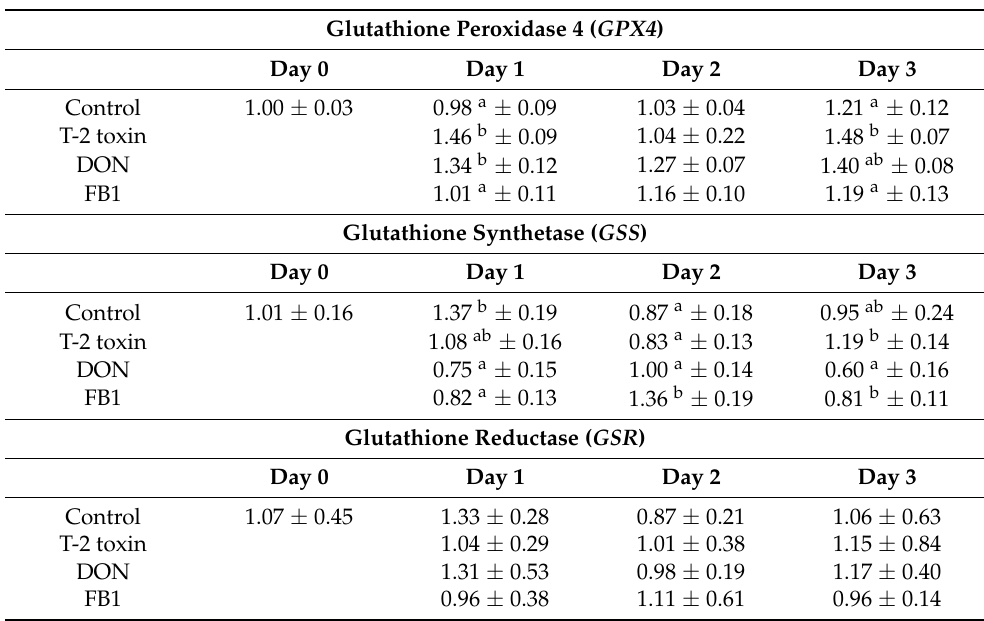
Table 7. Short-term effect of T-2 toxin, deoxynivalenol (DON), and fumonisin B 1 (FB1) treatment on the relative gene expression of the members of the glutathione redox system in the liver of laying hens (mean ± S.D.; n = 6; equal amounts of cDNA per animal). Glutathione Peroxidase 4 ( GPX4 ) Day 0 Day 1 Day 2 Day 3 Control 1.00 ± 0.03 0.98 a ±